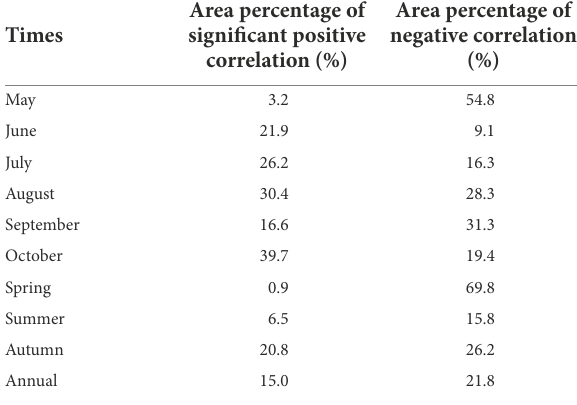
TABLE 2 The spatial area percentage of correlation between NDVI and SPEI lagged period